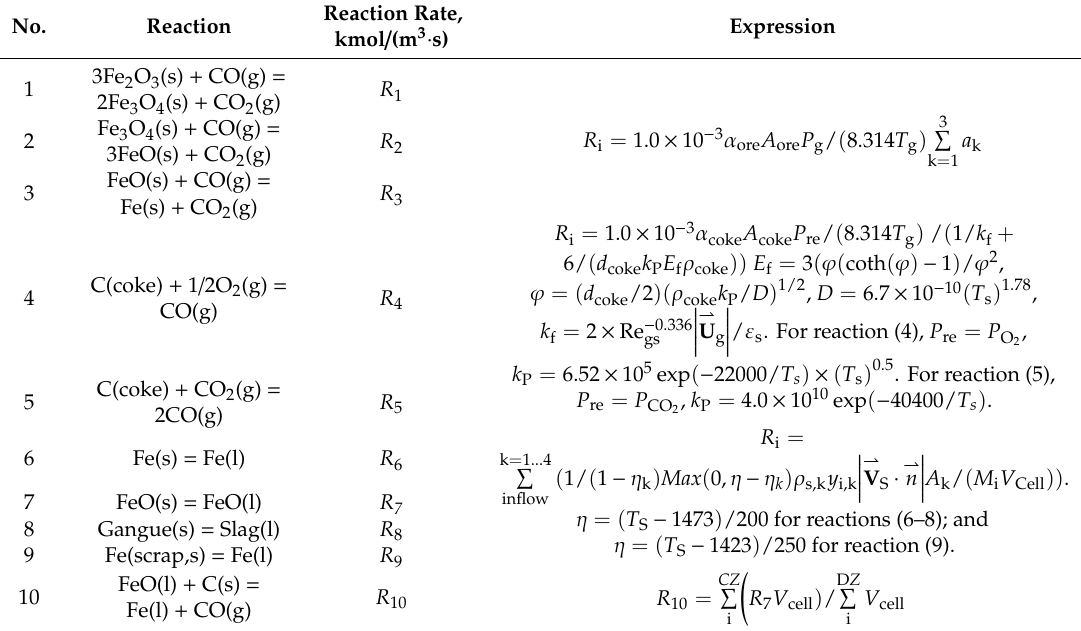
Table 4. Chemical reactions involved in the model.